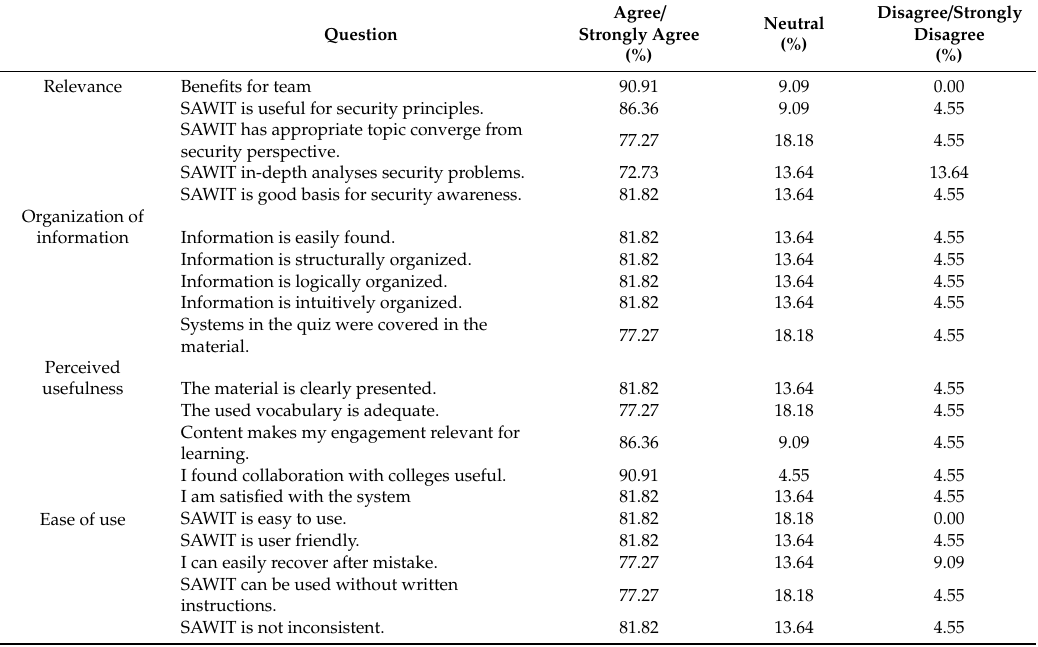
Table 1. Likert scale questionnaire